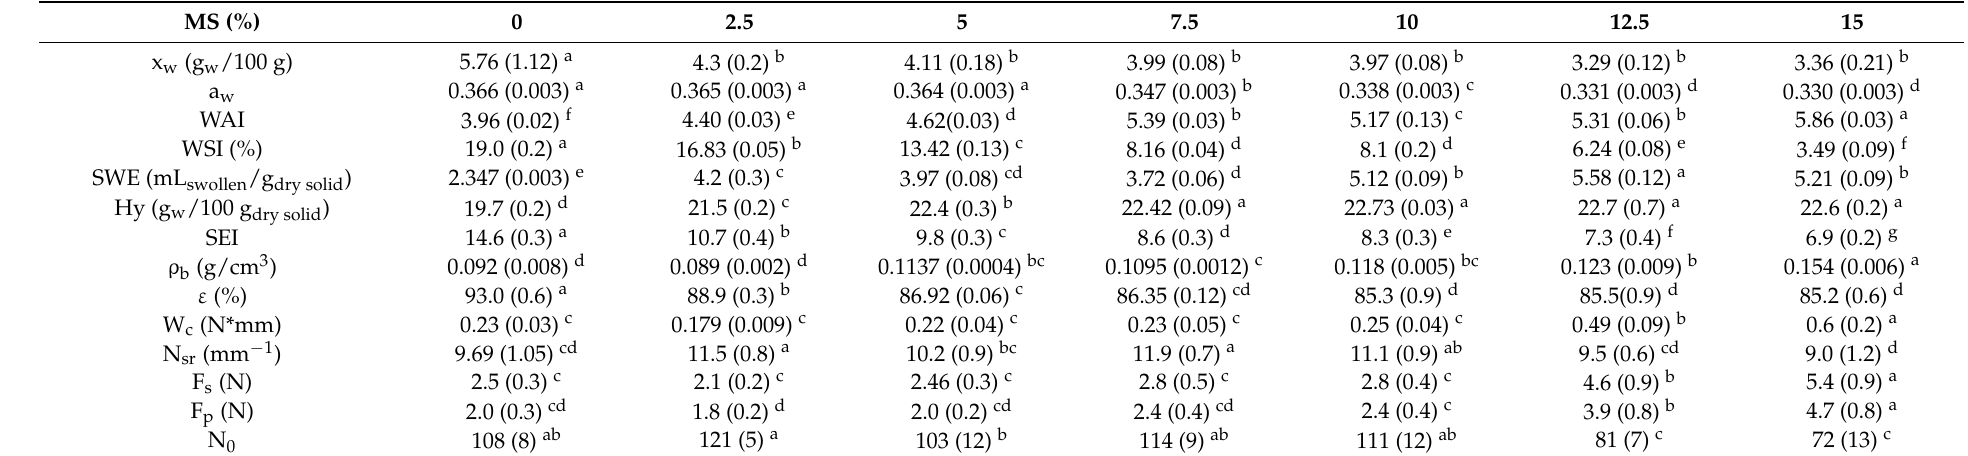
The same letter in superscript within a row indicates homogeneous groups established by ANOVA ( p < 0.05). All data represent the mean of three